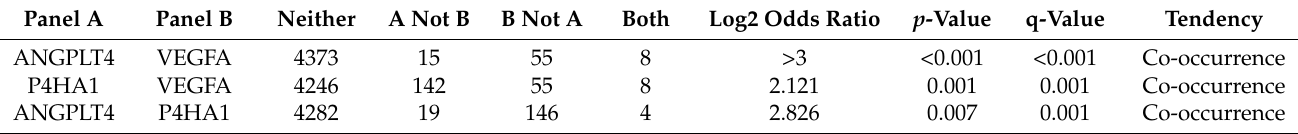
Table 4. Mutual exclusivity and co-occurrence of overexpressed hypoxia genes (cBioportal).